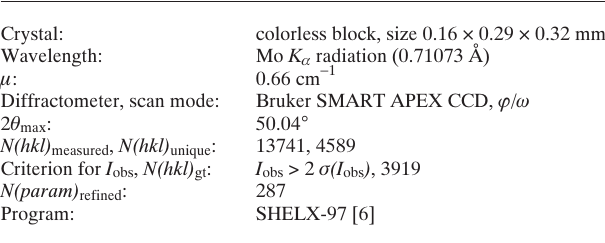
Table 1. Data collection and handling.